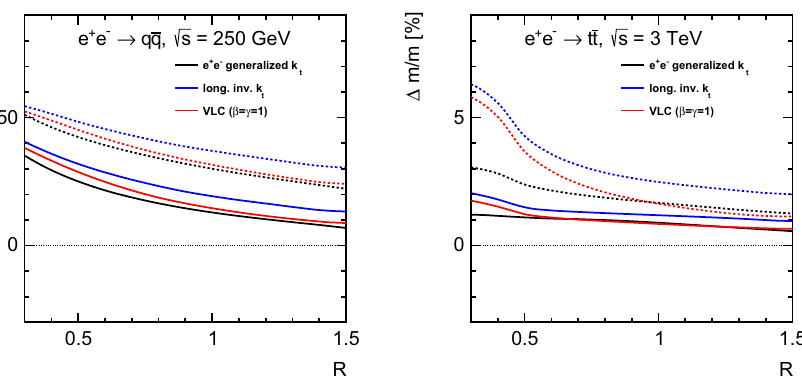
Fig. 7 Non-perturbative corrections to the jet mass as a function of the dashed line to the mean. Results are shown for three algorithms: the √ s = 250 GeV jet radius parameter R in e + e − → q ¯ q production at generalised e + e − algorithm, the longitudinally invariant k t algorithm √ s = 3 TeV (right panel). (left panel) and e + e − → t ¯ t production at and the VLC algorithm with β = 1. The statistical uncertainties of the results are negligible and are not The continuous line corresponds to the median relative correction, the